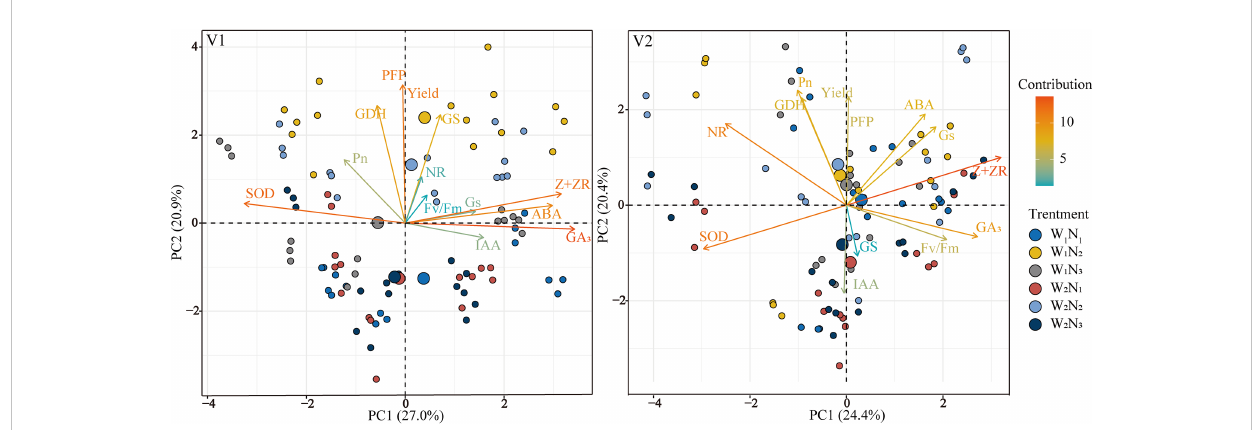
FIGURE 9 Principal component analysis of the main photosynthetic and physiological indices, yield, and NUE. P n , photosynthetic rate; G s , stomatal conductance; F v / F m , maximal photochemical ef fi ciency of PSII; SOD, superoxide dismutase; NR, nitrate reductase; GS, glutamine synthetase; GDH, glutamate dehydrogenase, ABA, abscisic acid; IAA, indole acetic acid; GA 3 , gibberellic acid; Z+ZR, zeatin riboside. V1 and V2 represent T-43 and Liangxiang-3, respectively. PC, principal